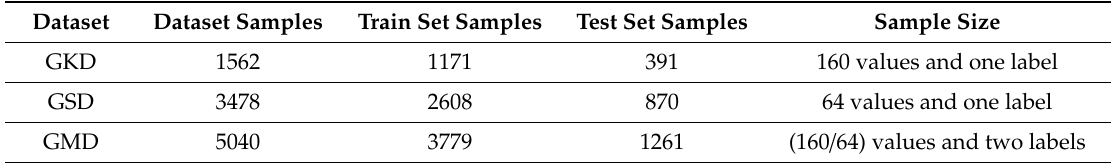
Figure 1. Graspable objects in dataset. Table 1. Statistics of datasets.